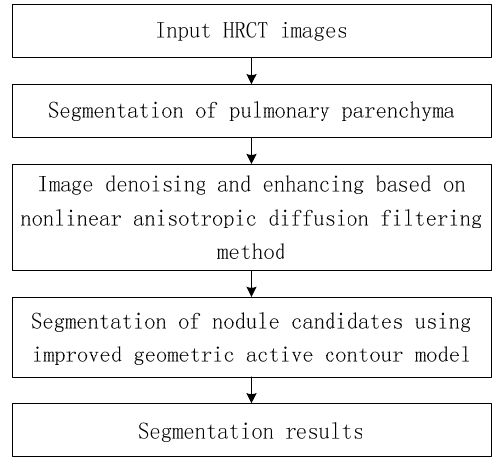
Fig. 2. Flowchart of segmentation process of